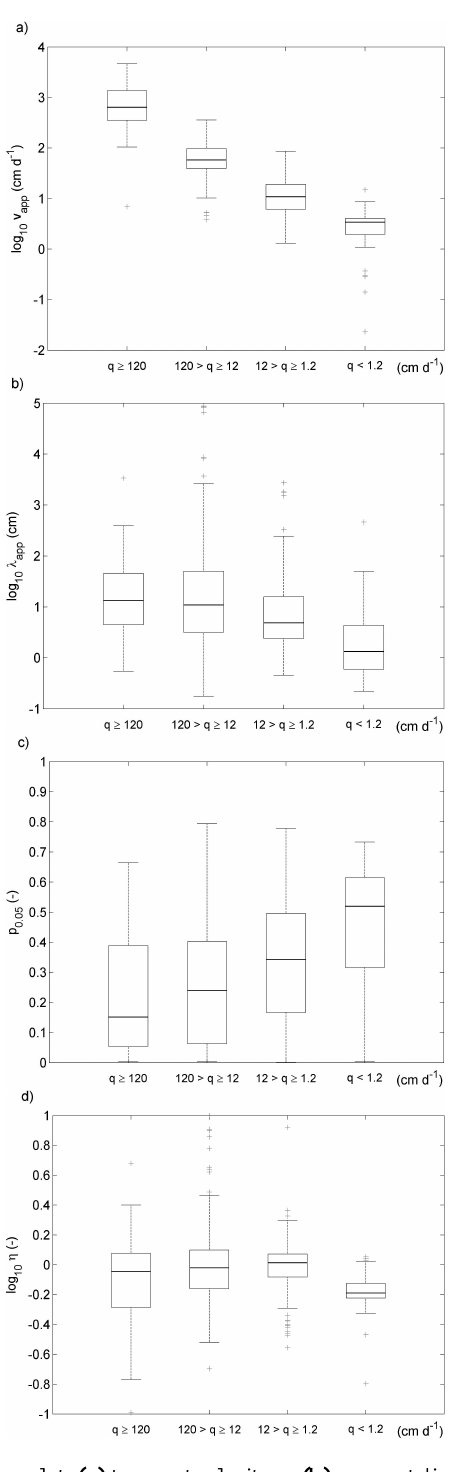
Fig. 6. Boxplots (a) transport velocity, v , (b) apparent dispersivity, λ app , (c) normalized 5%-arrival time, p 0 . 05 , and (d) piston-flow to transport velocity ratio, η according to the respective water flux class. Note that this figure is based on BTCs from undisturbed soil samples only.